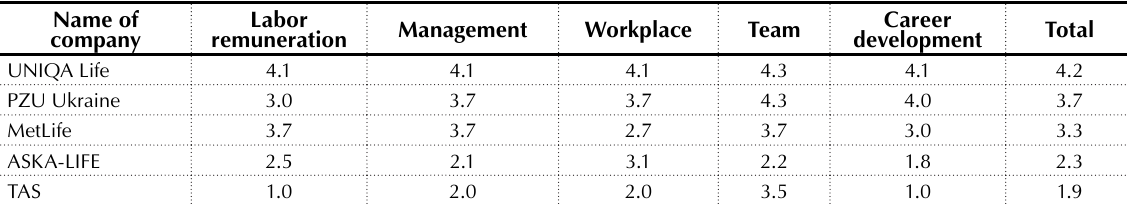
Table 9. Assessment of employers by